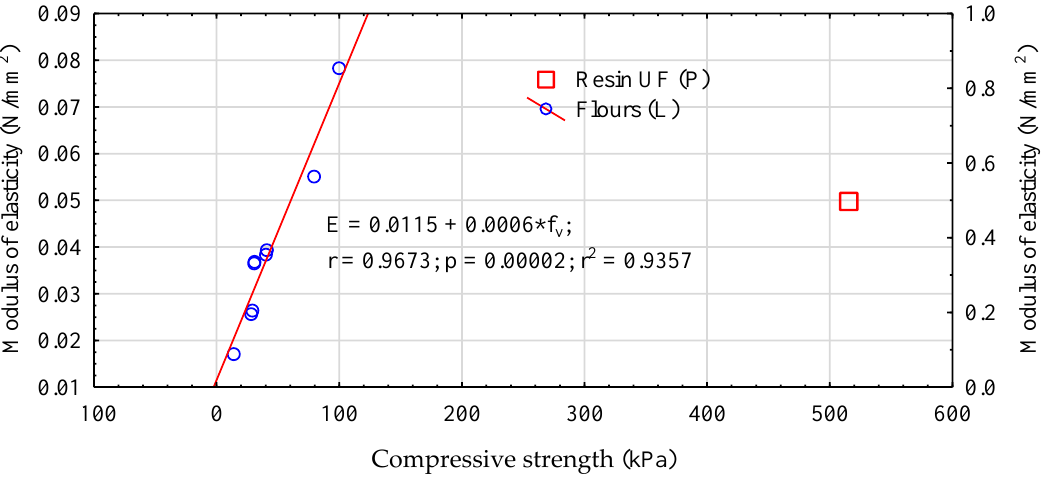
Figure 2. Correlation of modulus (E) of elasticity with compressive strength (f v ). The obtained values of thermal conductivity range from 0.037 to 0.039 W/(m · K), and it is rather difficult to assess the effect of applied modifications. Since these values are consistent with the reports of manufacturers of insulation boards produced from pulp, it needs to be assumed that this parameter is more strongly dependent on fiber quality and panel density, rather than the applied fiber bonding agent.